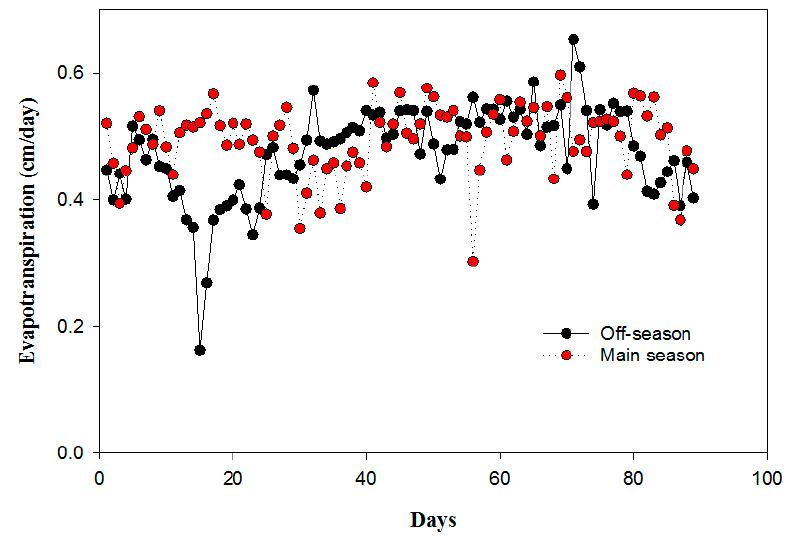
Figure 3. Comparison of daily crop evapotranspiration in a paddy plot during two rice growing seasons (January to October 2017).